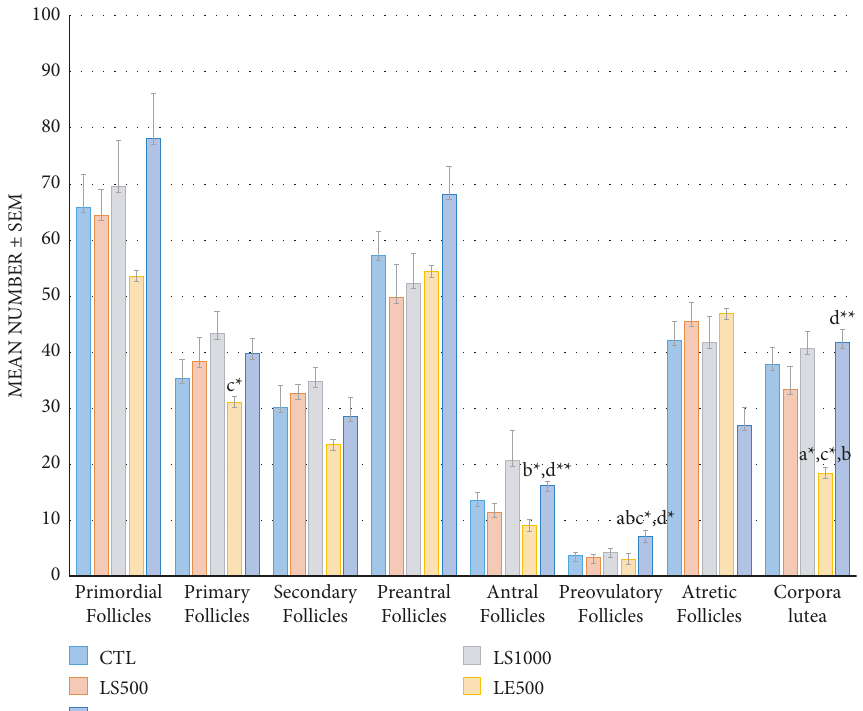
Figure 2: Effect of in vivo administration of hydroalcoholic extract and flaxseed on the number of different follicles including primordial, primary, secondary, preantral, antral, preovulatory, and atretic follicles. The values are represented as mean ± SEM ( n � 7/group). a A significant difference in comparison with the CTL group. b A significant difference in comparison with the LS500 group. c A significant difference in comparison with the LS1000 group. d A significant difference in comparison with the LE500 group. The statistical values ∗ P < 0 . 05, ∗∗ P < 0 . 01, and ∗∗∗ P < 0 . 001 represent a significant difference among the groups.